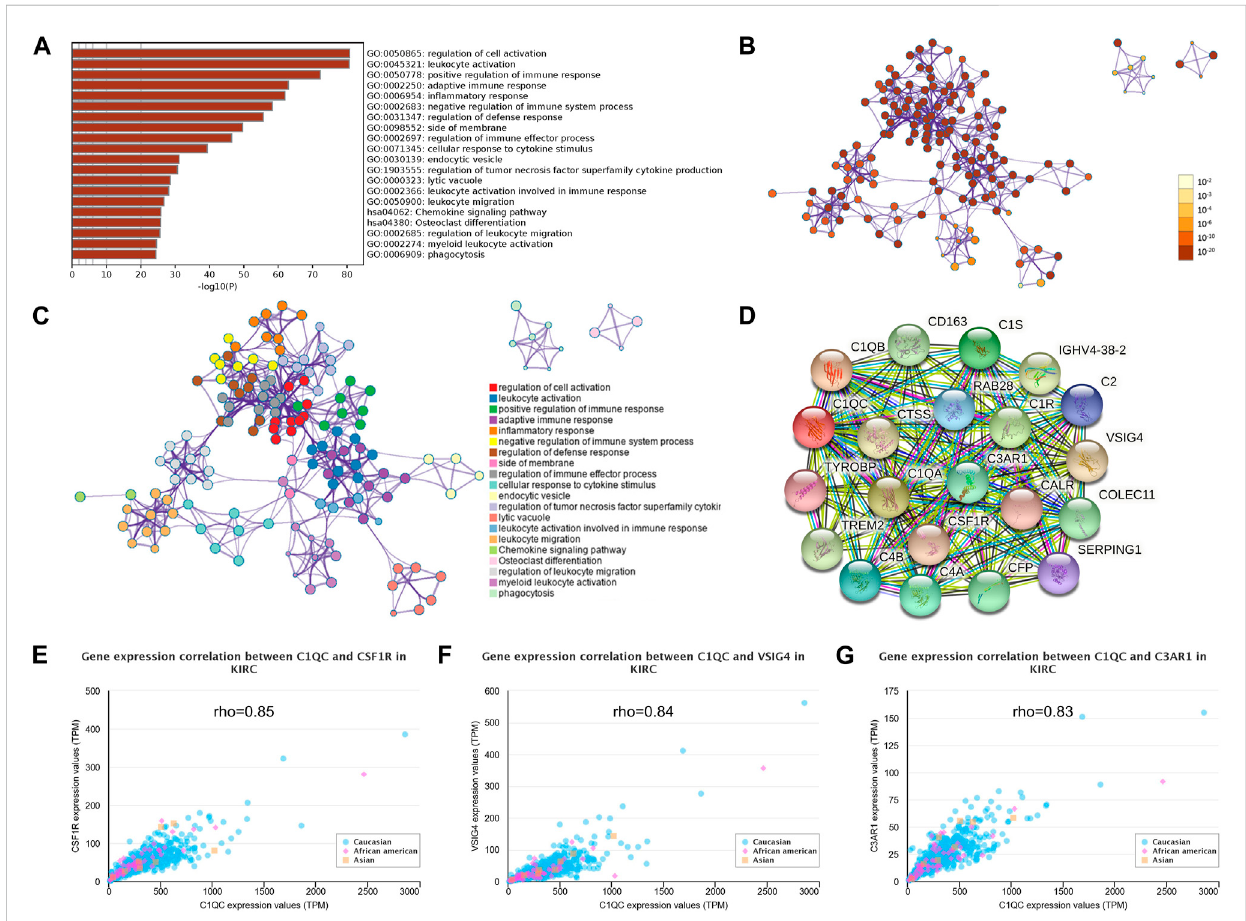
FIGURE 4 Genes and proteins co-interacted with C1QC show a relevance to immune-related signaling pathway. (A) KEGG and GO analysis results of genes co-expressed with C1QC in KIRC. (B) p -value colored network of enriched terms; p values for terms that have a larger number of genes are usually smaller. (C) Cluster ID-colored network of enriched terms; nodes sharing the same cluster ID usually approach to each other. (D) C1QC-proteins interaction. (E – G) Association analysis of C1QC with CSF1R, VSIG4, and C3AR1 in different ethnic